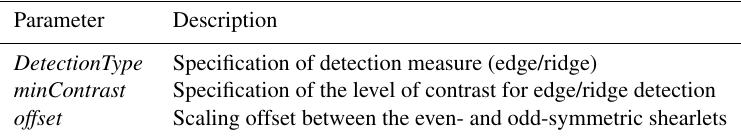
alpha octaves Number of octaves spanned by the shearlet system Table 2. Detection parameters.